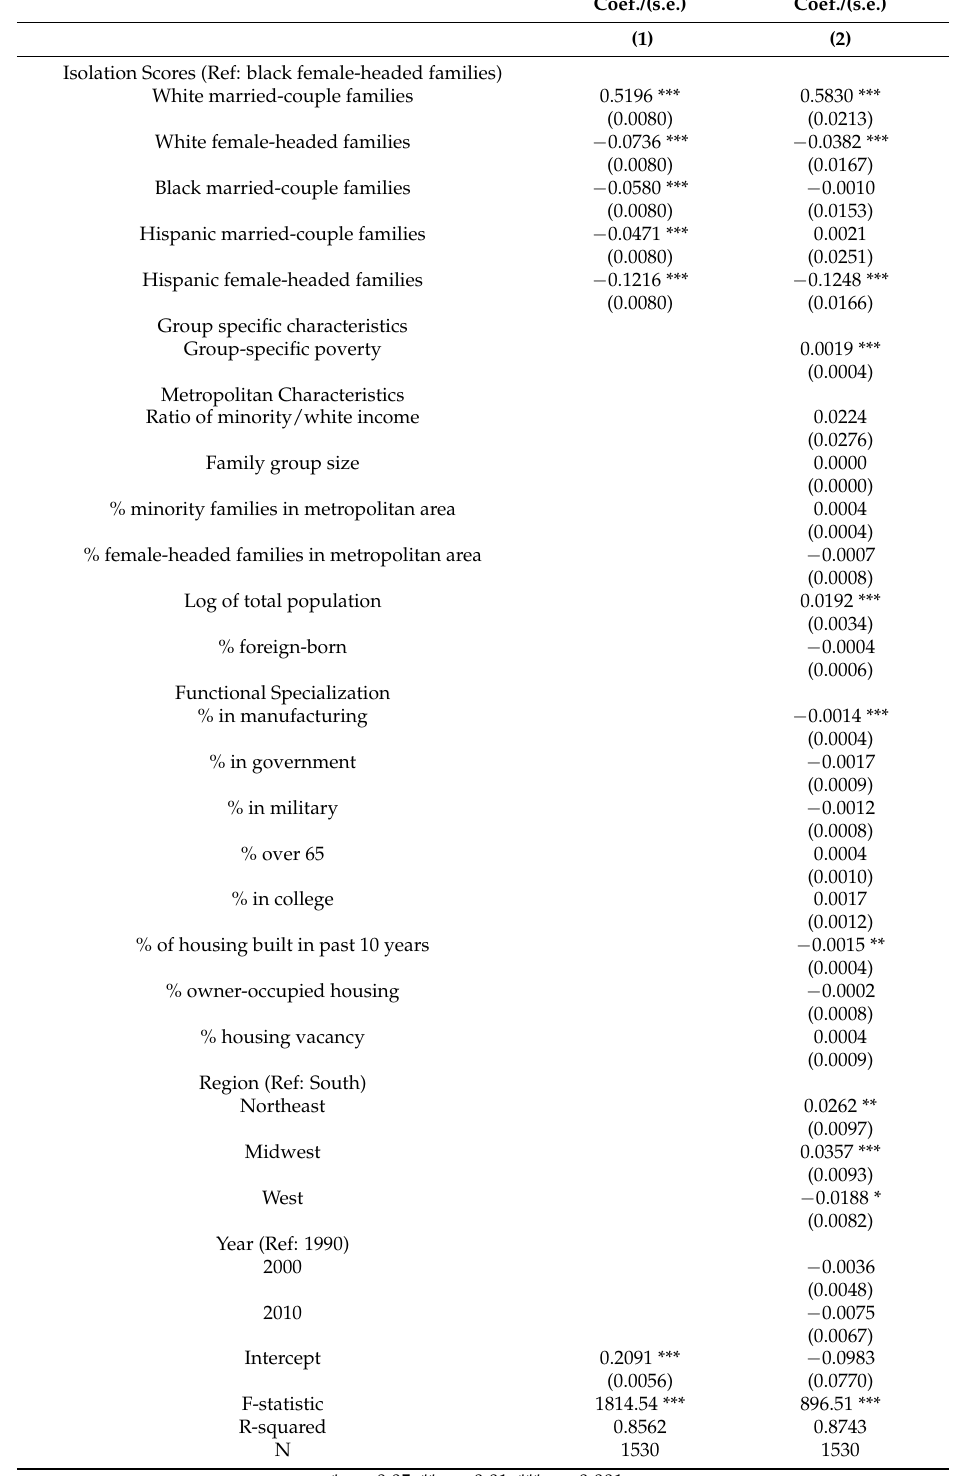
Table 6. Linear regression models of the association between family structure and the Isolation Index relative to black female-headed families, using the 1990–2010 NCDB and 1990–2010 NHGIS.